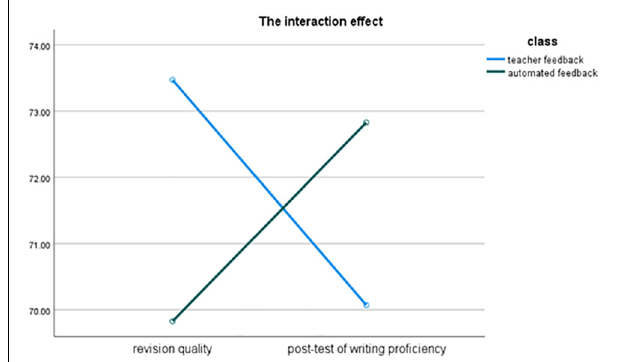
FIGURE 1 | The interaction effect between writing occasion and feedback